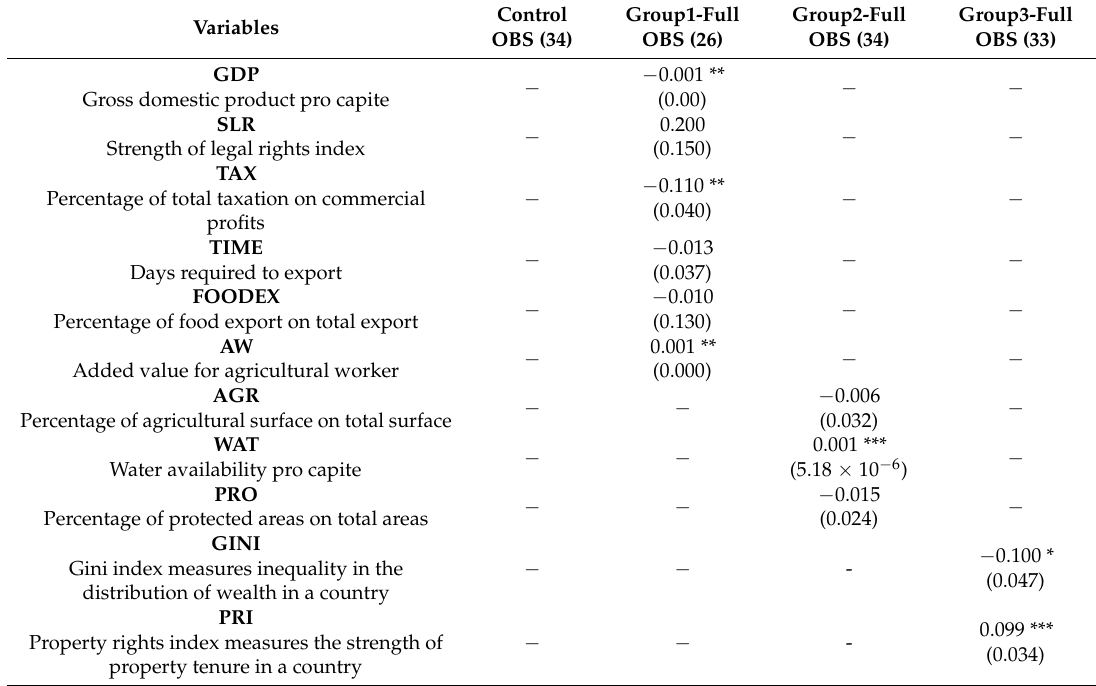
Table 7. Results of regression